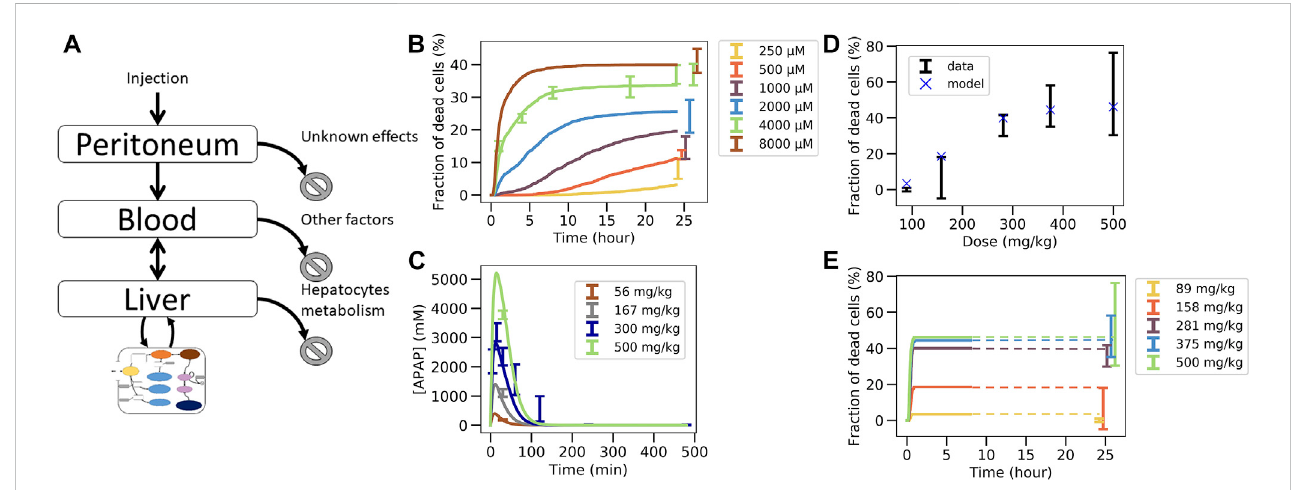
FIGURE 6 Simultaneous fi t to in vitro toxicity data and in vivo pharmacokinetic data strategy. (A) Scheme of the model, (B) fi t to in vitro toxicity data, (C) fi t to in vivo pharmacokinetic data, (D) extrapolation to in vivo toxicity data at 24 h after damage, (E) extrapolation to in vivo toxicity data over time. Simulations were ran only until 480min and since the fraction of dead cells saturates, the fi nal result at 24 h is extrapolated from there (illustrated by dotted